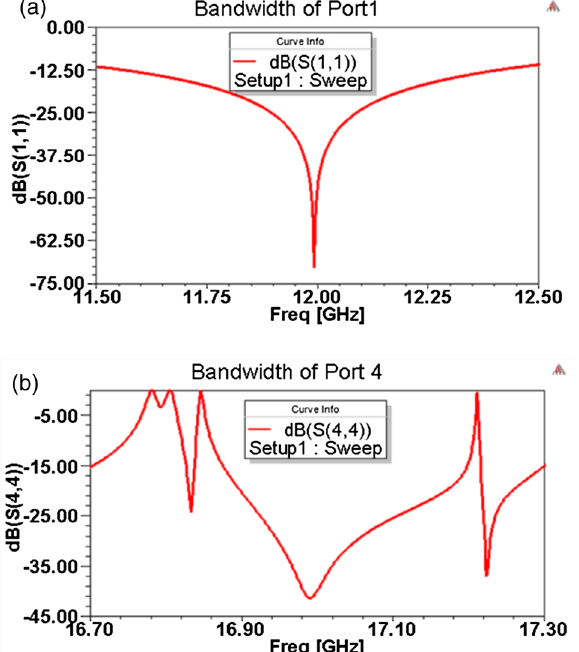
FIG. 26. Power coupling and HOM damping in (a) the coupler cell and (b) the HOMagic-T.